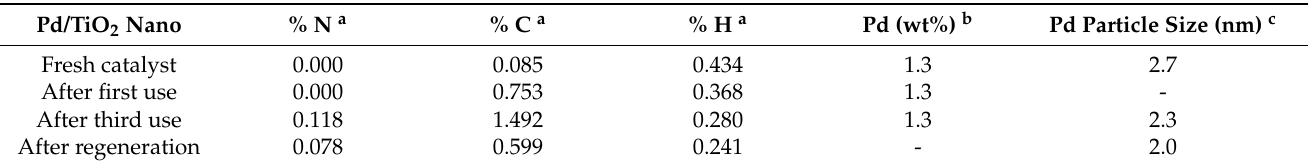
Table 4. Effect of reusability and regeneration with H 2 on carbon deposition over Pd/TiO 2 nano catalyst in the tars mild hydrotreatment.